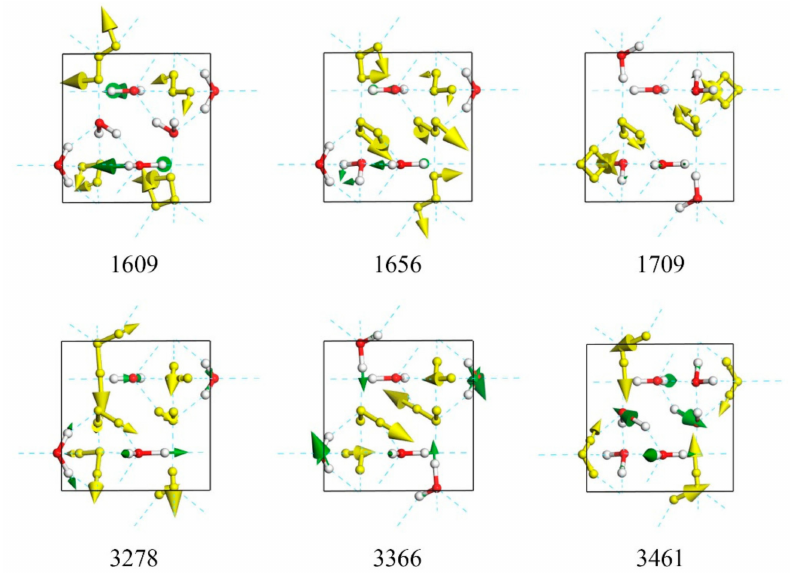
Figure 4. Top view of six normal modes in bending band (1609, 1656, and 1709 cm − 1 ) and stretching band (3278, 3366, and 3461 cm − 1 ), respectively. Mode at 3366 cm − 1 is a typical isolated stretching